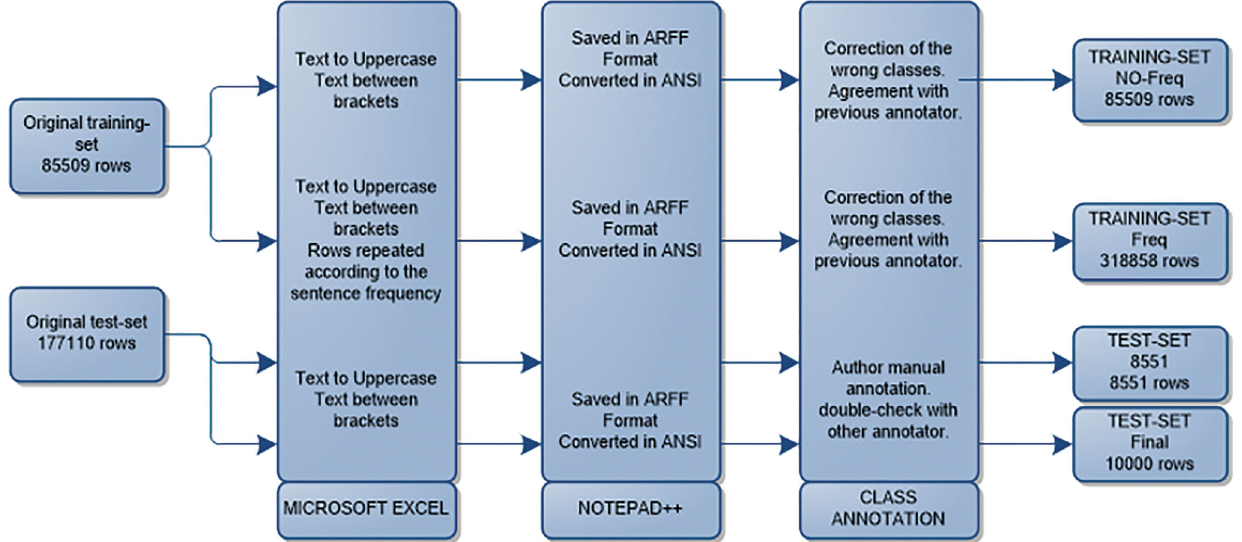
Figure 1. Description of the workflow used to pre-process data, to obtain coherent and manually classified training-sets and